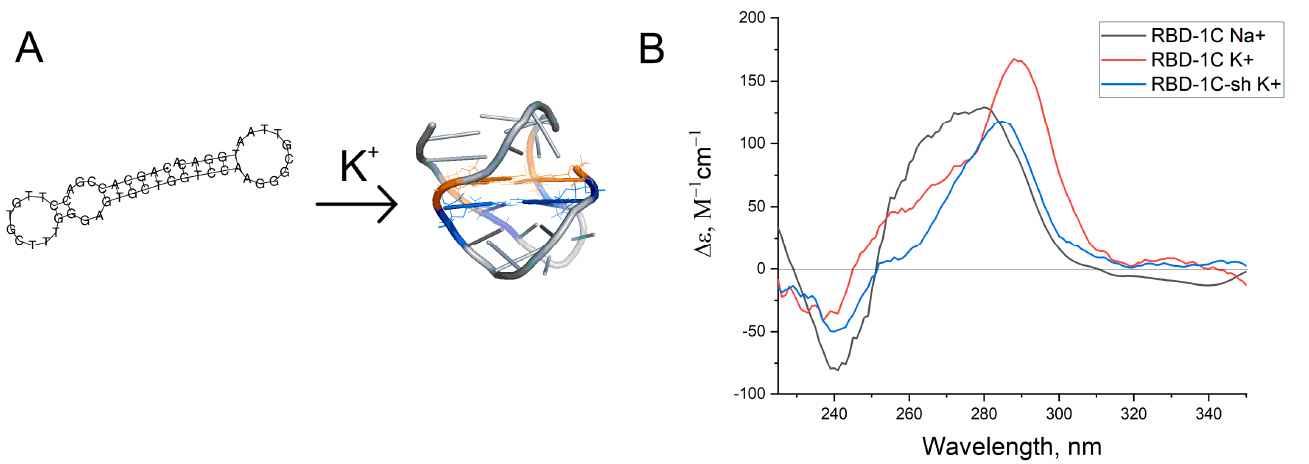
Figure 1. ( A ) Putative structures of the aptamer RBD-1C. ( B ) Circular dichroism spectra of RBD-1C in 140 mM NaCl (‘Na + ’), RBD-1C, and RBD-1C-sh in 140 mM NaCl and 10 mM KCl (‘K + ’).